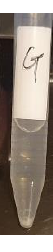
Figure 8. An example of precipitates containing microbial cells and insolubilized compounds in culture broth.